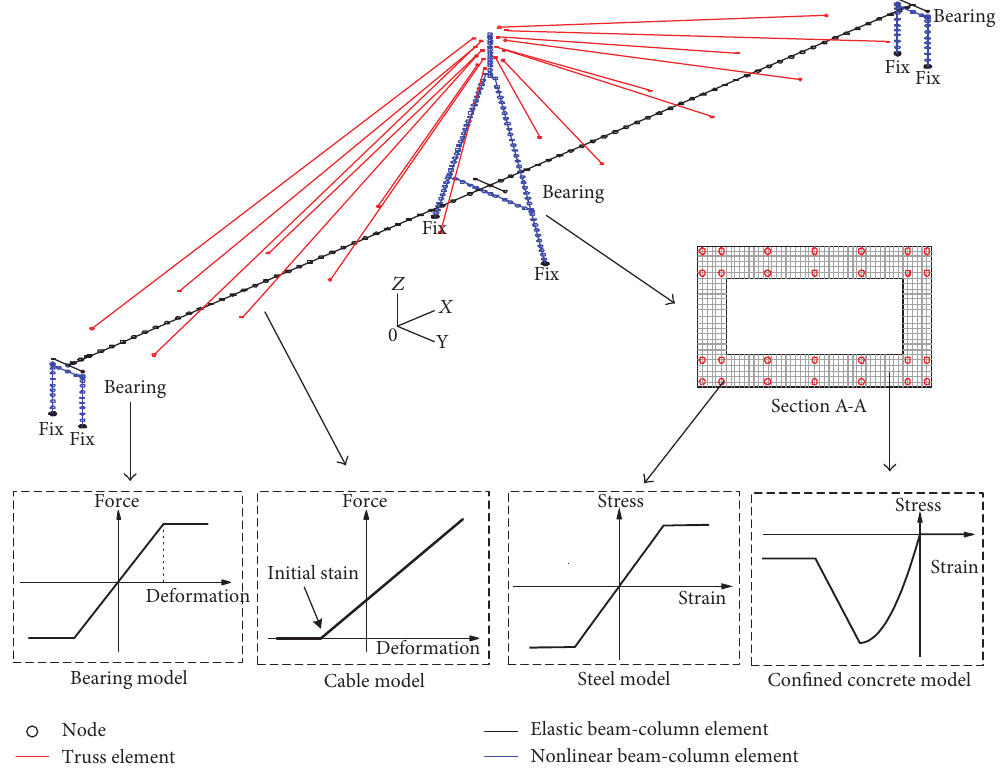
Figure 12: FEM model of Model